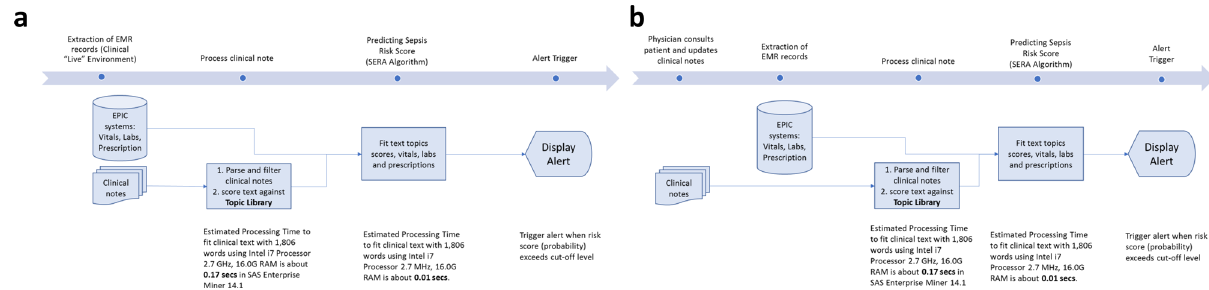
Fig. 5 Work fl ow for the setup of SERA algorithm within the clinical environment. a A proposed work fl ow for the SERA algorithm to operate in the background and provide alerts when key events (such as ward shift handovers) are triggered. b A proposed work fl ow for the SERA algorithm to run immediately after a physician updates a patient ’ s clinical notes in the